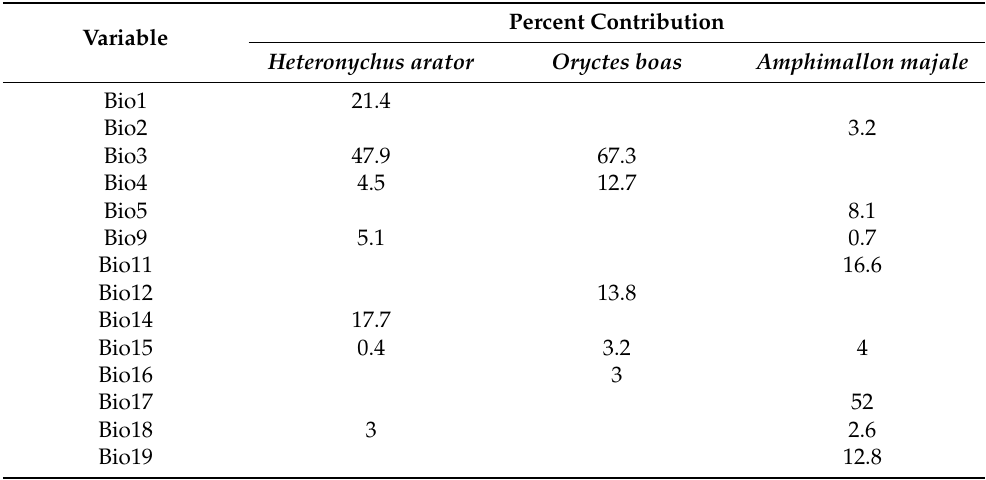
Table 2. Key bioclimatic variables and contributions of Heteronychus arator , Oryctes boas and Amphi- mallon majale